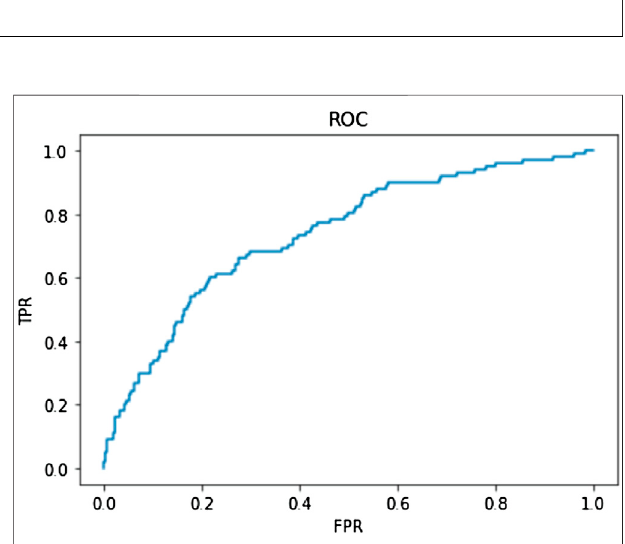
FIGURE 3 | The ROC